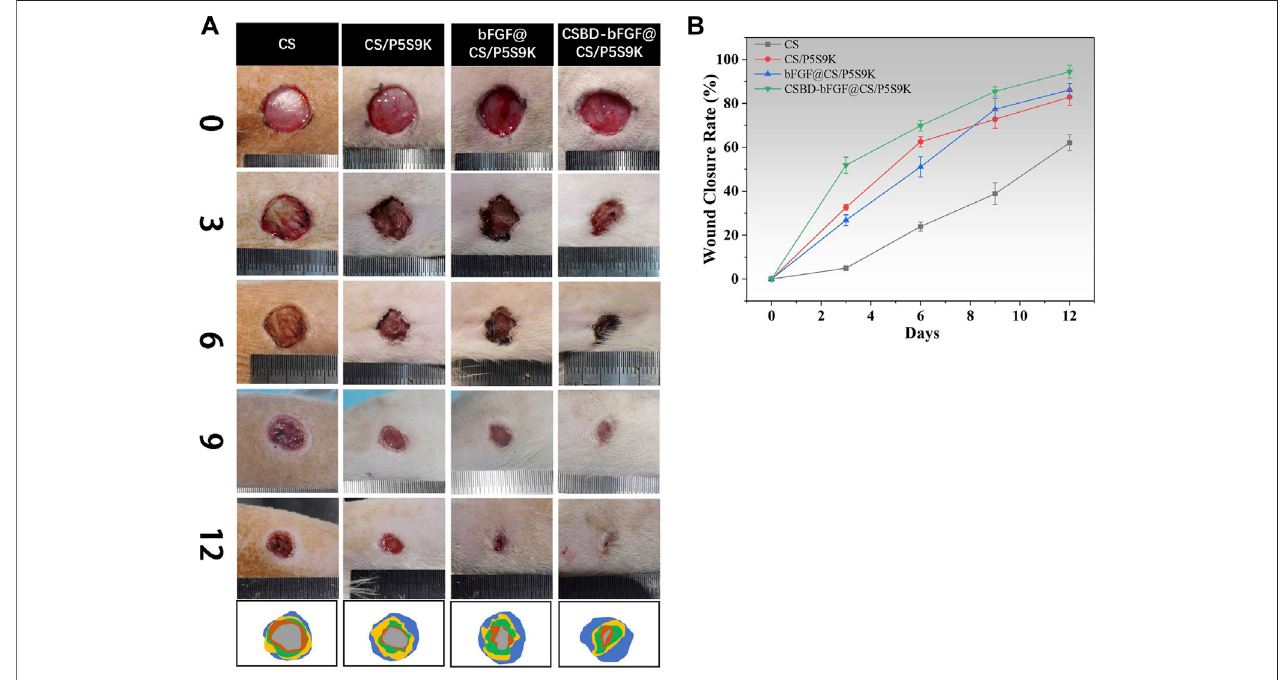
FIGURE 8 | (A) Photographic images of the wound healing status and (B) the wound-healing